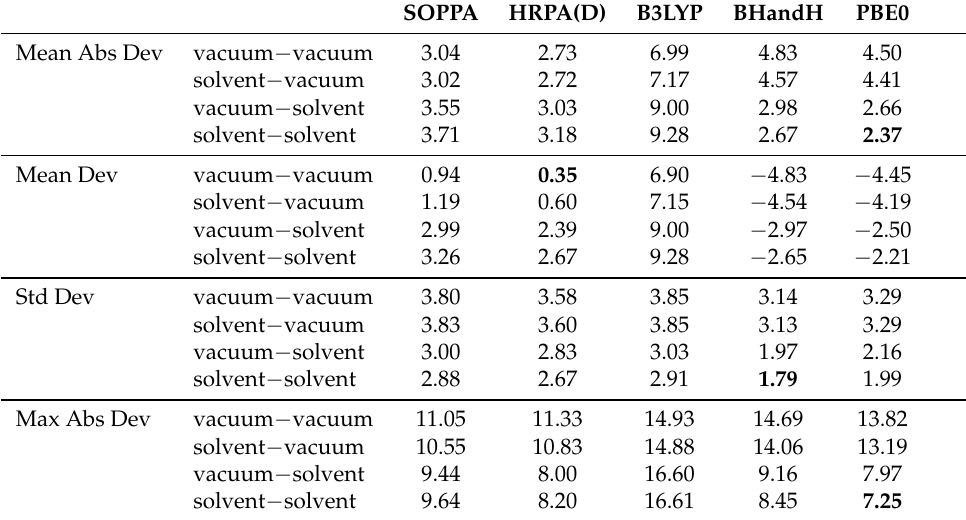
Figure 3. The statistics for the 89 1 J CH coupling constants. Table 3. Statistical data for the 1 J CH